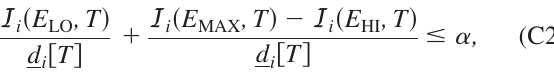
FIG. 13. Cumulative integrals of channel-wise spectrum- response products over the interval ½ 0 ; E R I E ½ E; T (cid:7) ¼ ð E 0 Þ S ð E 0 ; T Þ dE 0 , where S R i i bb 0 malized Planckian spectral shape for temperature T . The curves shown represent combinations of i ¼ 1 ; 5 and T ¼ 60 ; 250 eV . spectral temperatures but are not shown for clarity.) The right- ð E Þ S ð E Þ . The vertical, dashed lines indicate the R i bb